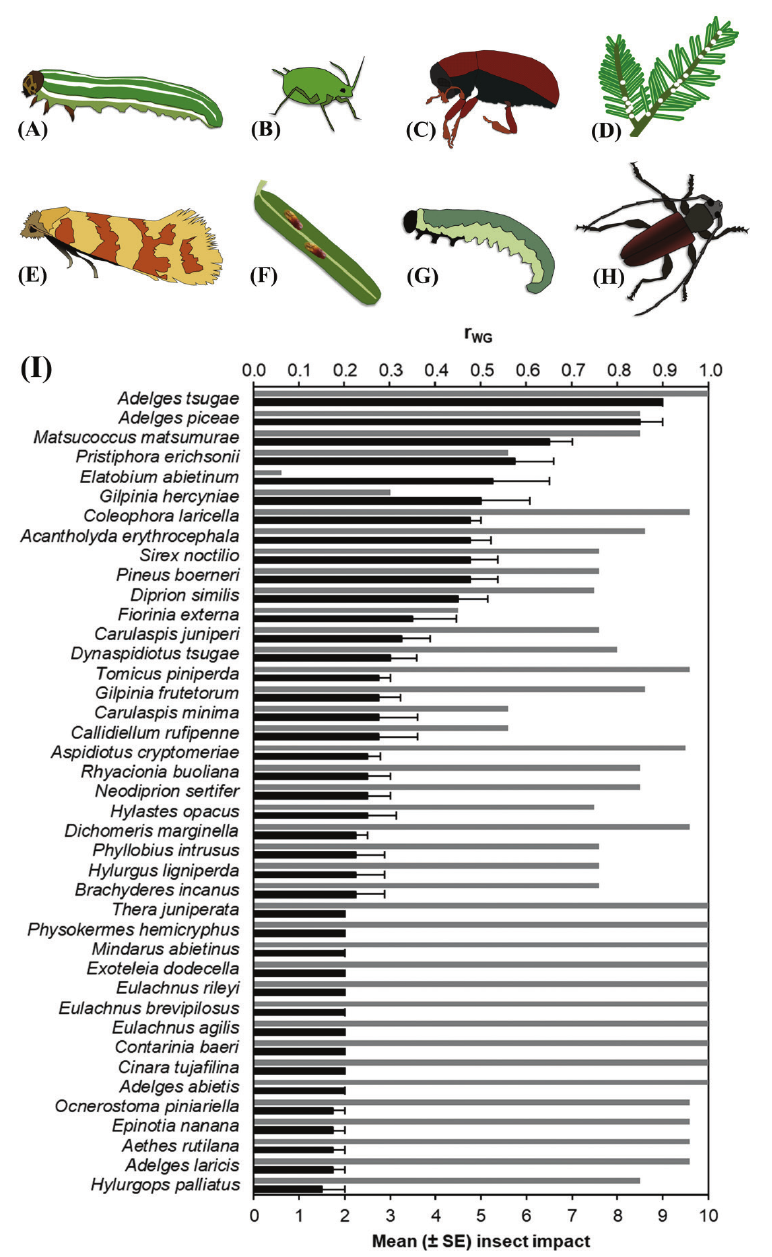
Figure 2. Examples of non-native, conifer-specialist insects, including ( A ) European spruce sawfly ( Gilpinia hercyniae ), ( B ) spruce needle aphid ( Elatobium abietinum ), ( C ) lesser spruce shoot beetle ( Hylurgops pallia- tus ), ( D ) hemlock woolly adelgid ( Adelges tsugae ), ( E ) pale juniper webworm ( Aethes rutilana ), ( F ) elongate hemlock scale ( Fiorinia externa ), ( G ) larch sawfly ( Pristiphora erichsonii ), and ( H ) Japanese cedar longhorned beetle ( Callidiellum rufipenne ) with the ( I ) mean ( ± SE) insect impact score (black bars) and within-group interrater agreement index ( r , gray bars) for all 41 conifer-specialist insects assessed in this WG